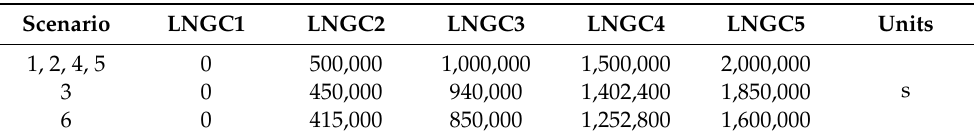
Table 4. Arrival schedule for each